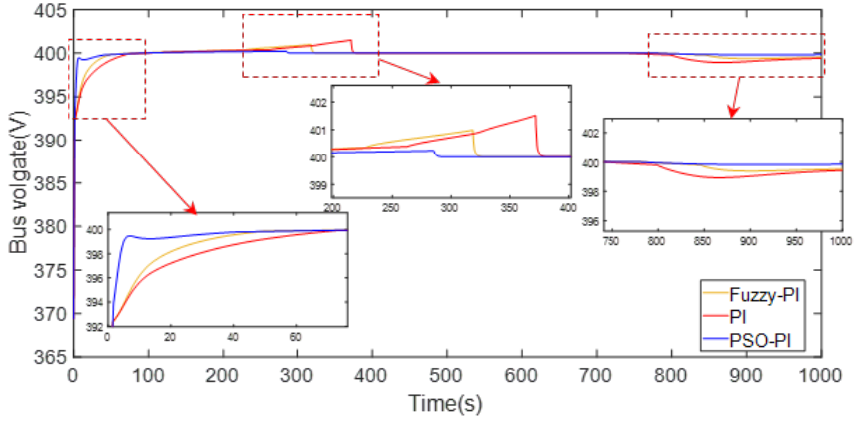
Figure 27. Bus voltage in Example 3.